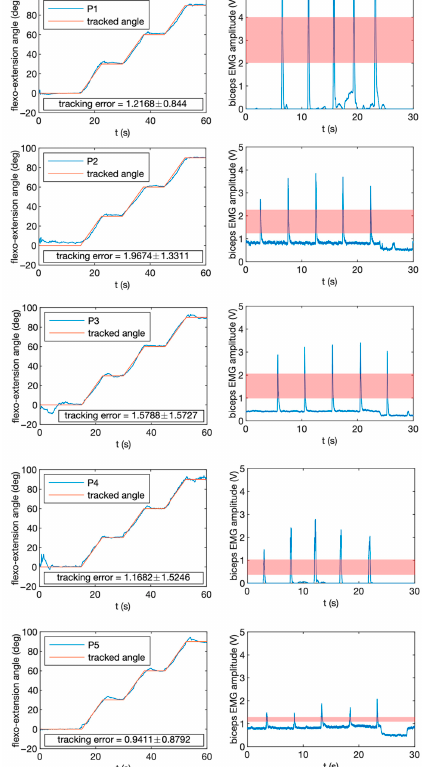
Figure 4. Results obtained for participants P1–P5. Experiment 1: Tracked angle vs. recorded angle, including mean tracking error. Experiment 2: Performance of 5 biceps contractions and proposed threshold range.